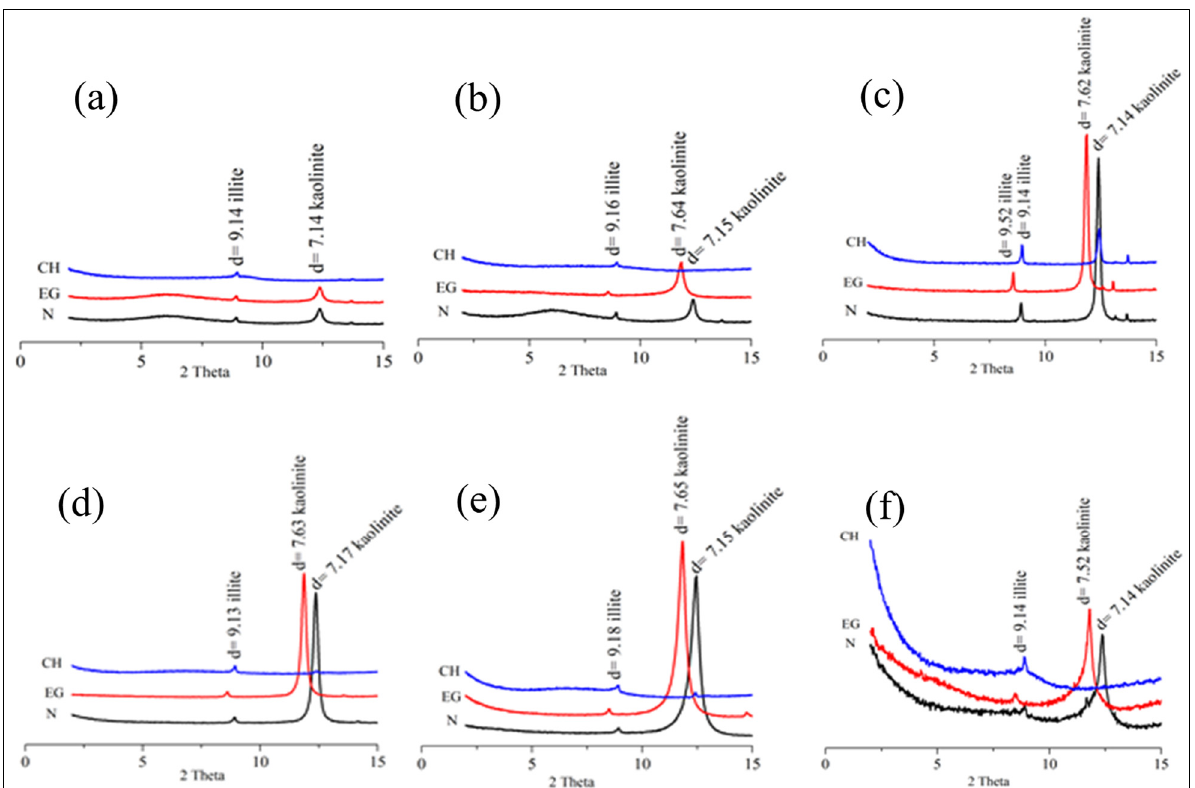
Figure 5. XRD patterns of the clay fraction: ( a ) Y1C1; ( b ) Y1C3; ( c ) J1C2; ( d ) J1C3; ( e ) N1C2 and ( f ) N1C4. N: normal sample, CH: heated at 500 °C, EG: treated with ethylene glycol.